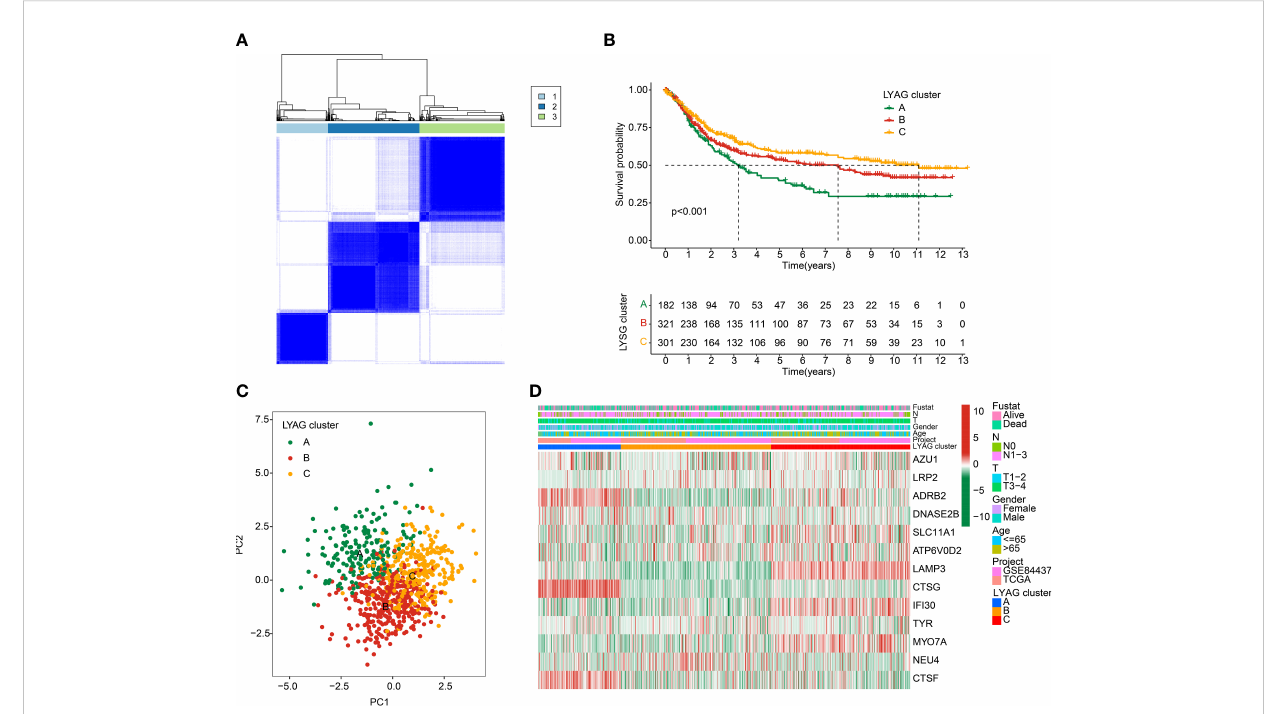
FIGURE 3 Identi fi cation of molecular subtypes for GC. (A) Unsupervised consensus clustering analysis for GC. (B) Clinical survival outcome of GC in LYAG clusters. (C) PCA score plot of LYAG cluster subgroups. (D) Characteristics of clinicopathological and LYAGs expression in GC subtypes.